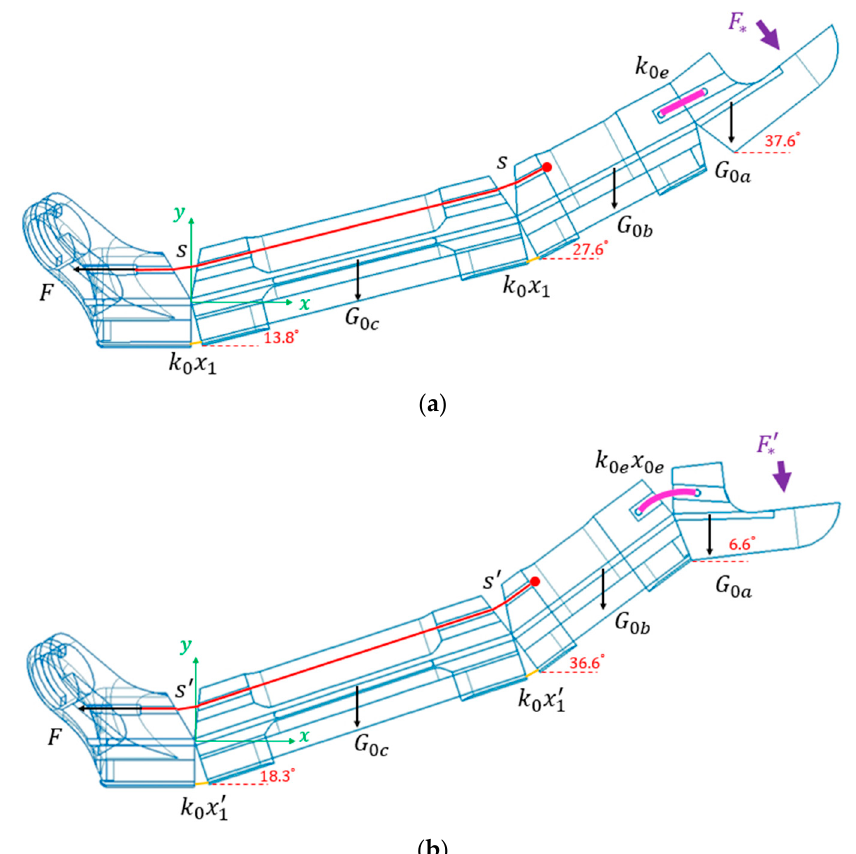
Figure 15. Mechanics analysis for thumb hyperextension: ( a ) initial state; ( b ) complete hyperextension Figure15. Mechanicsanalysisforthumbhyperextension: ( a )initialstate; ( b state.